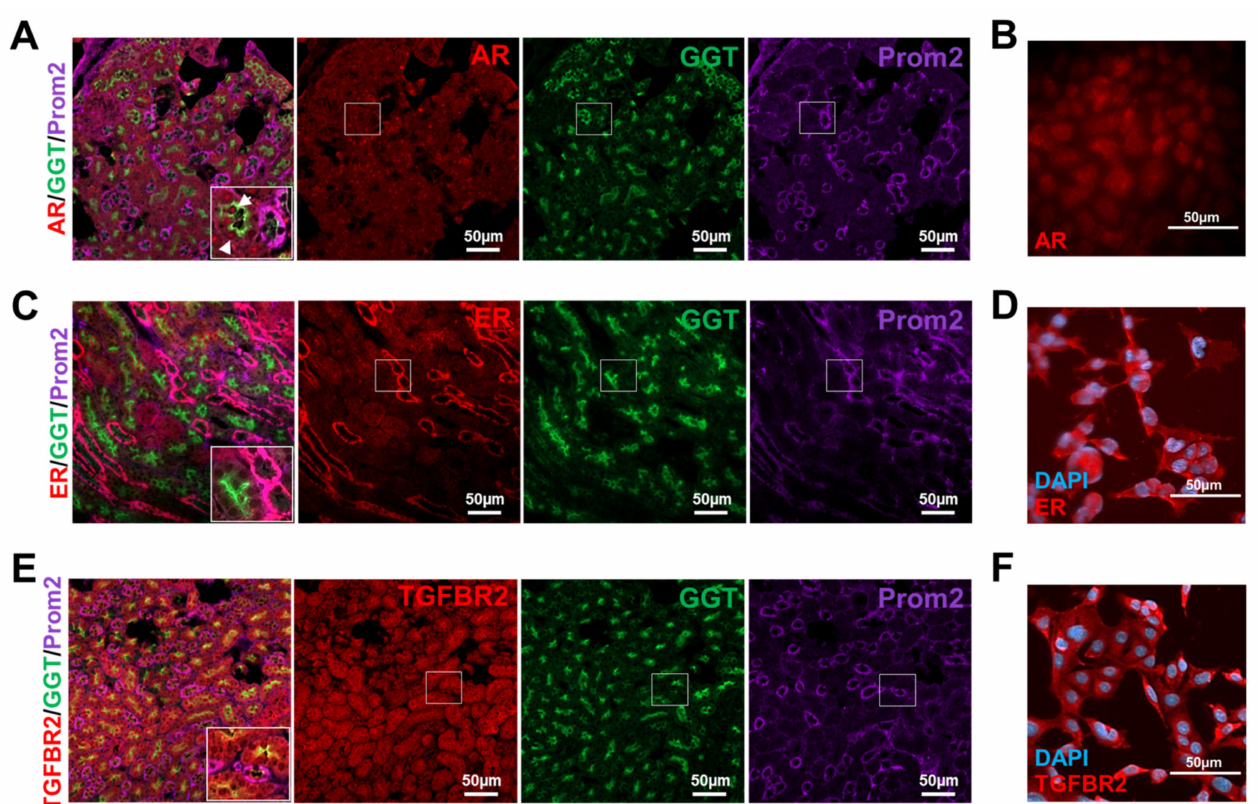
Figure 3. Expression of receptors for sex hormones and TGF- β 1 in renal cortical tissue and TKPTS cells. ( A ) Androgen receptor (AR) immunofluorescence (red) of kidney sections with co-staining of marker for proximal tubular cells GGT (green) and marker for distal tubules Prom2 (purple). Arrows: AR and GGT co-stained cells. Magnification 200 × . ( B ) Androgen receptor (AR) immunofluorescence (red) of TKPTS cells (magnification 400 × ). ( C ) Estrogen receptor (ER) immunofluorescence (red) of kidney sections with co-staining of marker for proximal tubular cells GGT (green) and marker for distal tubules Prom2 (purple). Magnification 200 × . ( D ) Estrogen receptor (ER) immunofluorescence (red) of TKPTS cells, co-stained with DAPI (blue) (magnification 400 × ). ( E ) TGF- β receptor 2 (TGFBR2) immunofluorescence (red) of kidney sections with co-staining of marker for proximal tubular cells GGT (green) and marker for distal tubules Prom2 (purple). Magnification 200 × . ( F ) TGF- β receptor 2 (TGFBR2) immunofluorescence (red) of TKPTS cells, co-stained with DAPI (blue) (magnification 400 × ). DAPI: 4’,6-diamidino-2-phenylindole; GGT: gamma-glutamyl transferase; Prom2: prominin